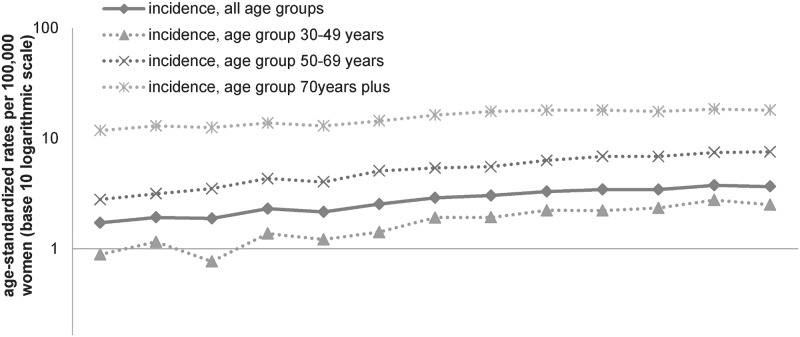
Vulvar cancer incidence rates from 1999–2011, stratified by age groups.Annual age-standardized vulvar cancer incidence rates per 100,000 women (old European Standard on a base-10 logarithmic scale), by calendar year, all ages (straight line), and for the age groups '30–49 years', '50–69 years', and '70 years plus' (dashed lines); DCO notified cases, histologically not further specified cases and melanoma excluded.